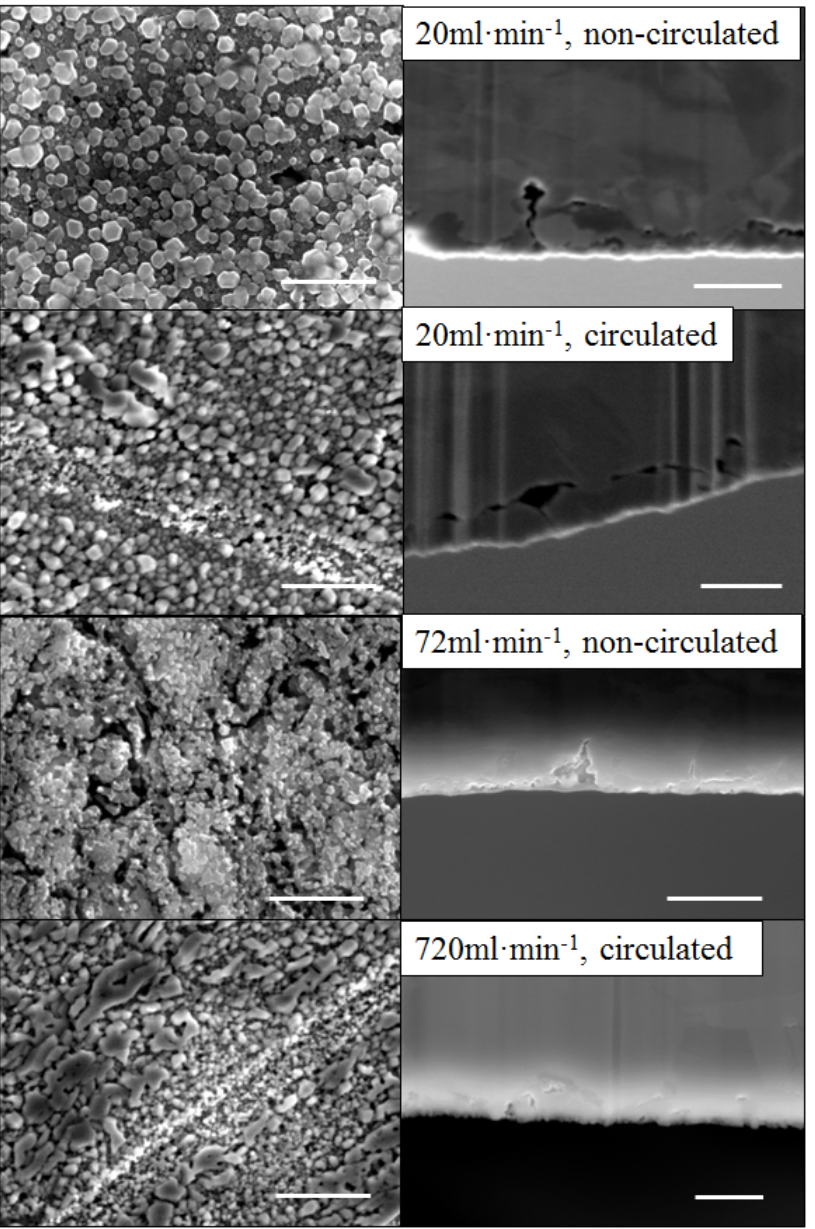
Figure 8. Surface and cross-section views of 1 M NaOH de-alloyed thin films with respective cross-flow surface velocities. Scale bars for the surface and cross section views correspond to 500 nm and 10 μm,